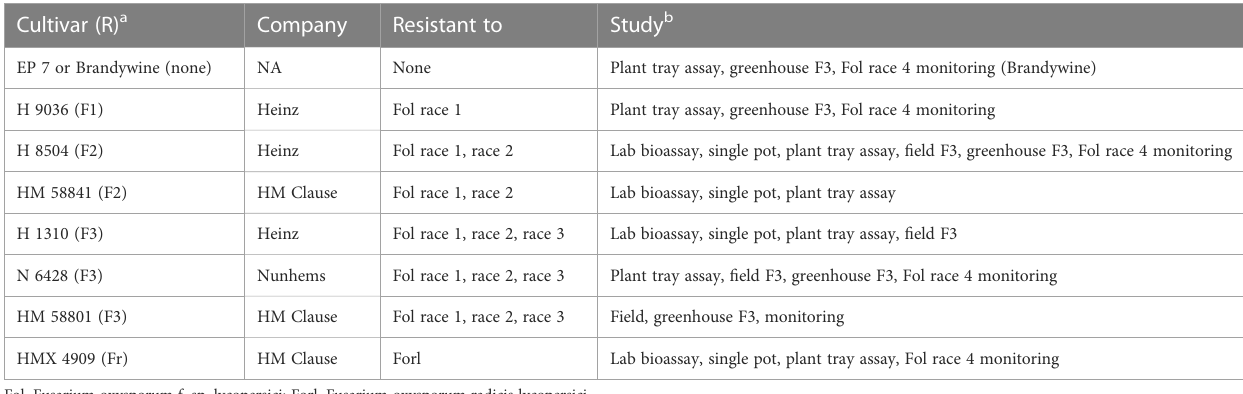
TABLE 1 Tomato cultivars used in all